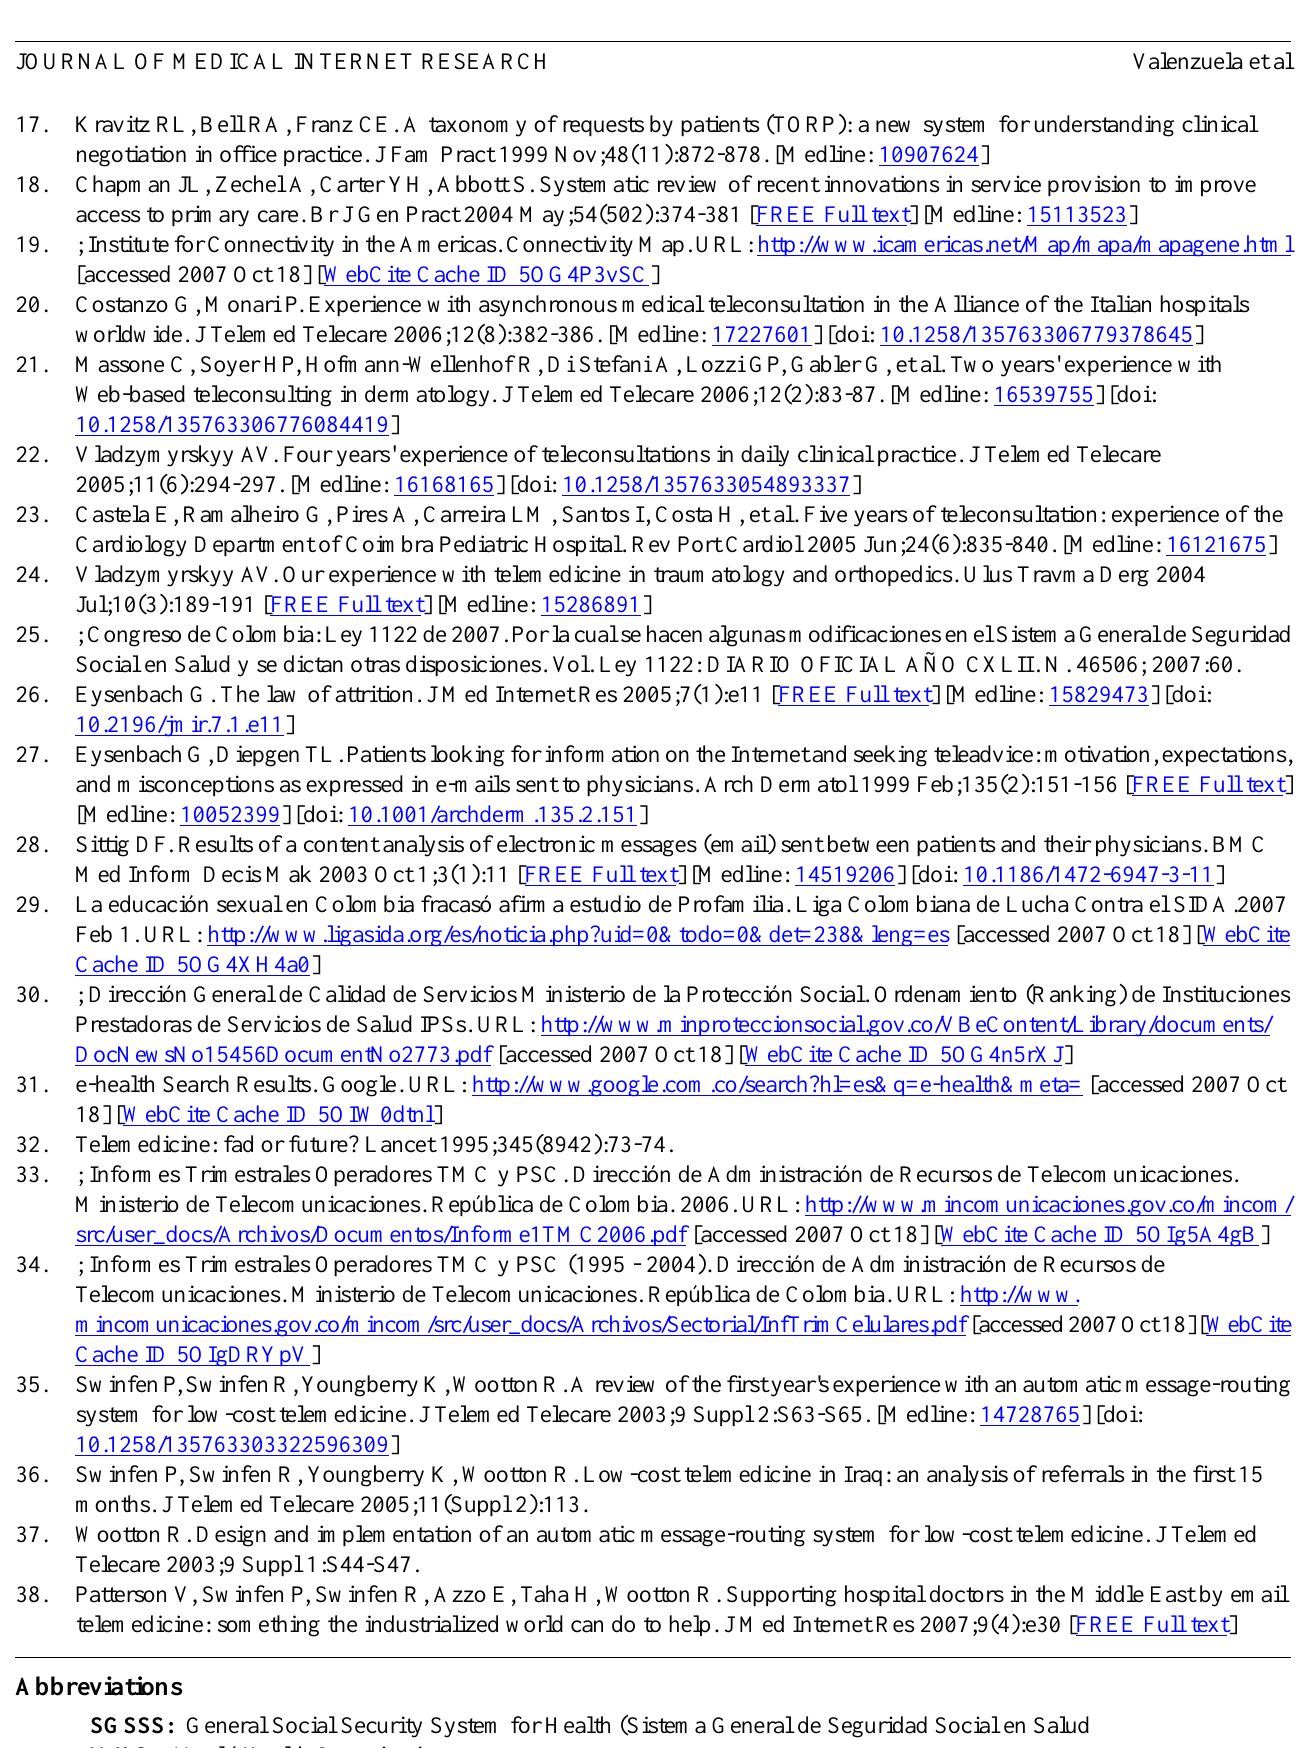
Abbreviations SGSSS: General Social Security System for Health (Sistema General de Seguridad Social en Salud WHO: World Health